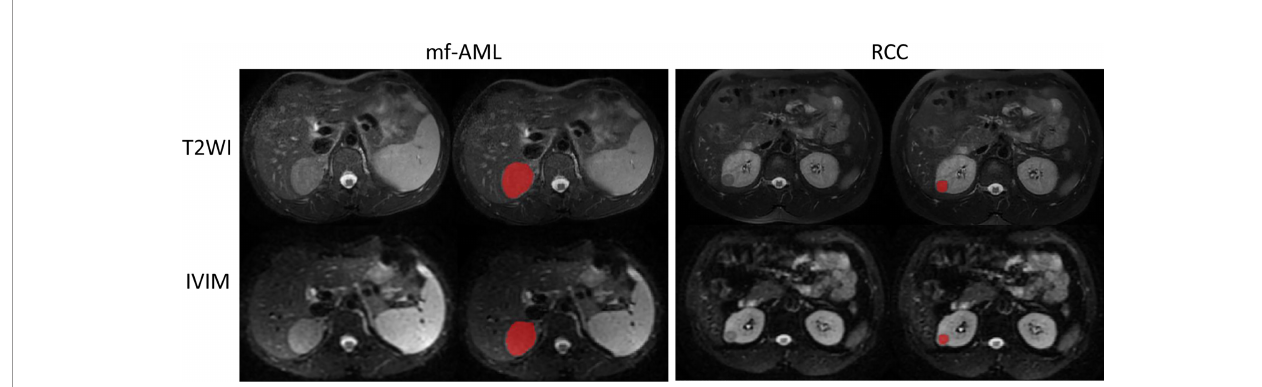
FIGURE 2 | Example of tumor segmented by the radiologist. The mf-AML and RCC were segmented on the T2-weighted image but the same segmentation has been copied to IVIM-DWI (b = 1000 s/m 2 ) image.